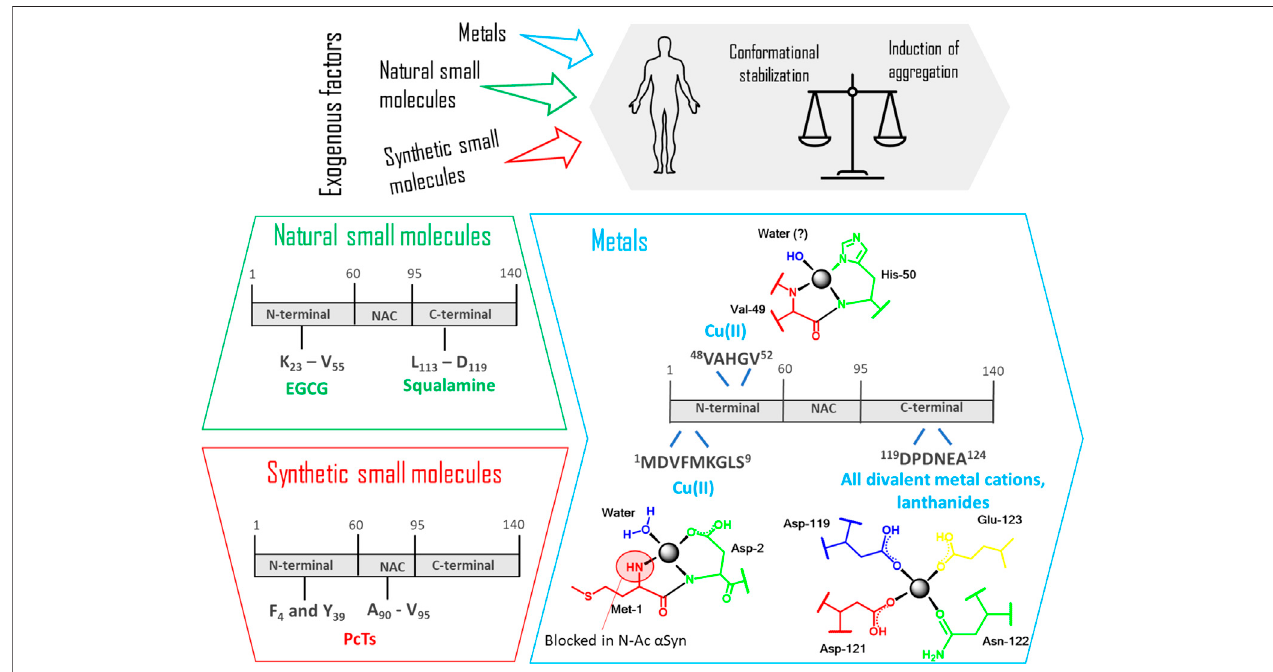
FIGURE 11 | Binding sites recognized in the interaction between α Syn monomer and different exogenous factors (natural and synthetic small molecules, metals). The coordination between the protein and these factors leads to a balance that is always shifting between conformational stabilization and induction of aggregation. In the box regarding “ metals, ” the speci fi c coordination modes of Cu(II), all divalent cations, lanthanides with the speci fi c amino acid residues are detailed. EGCG: Epigallocatechin gallate; PcTs: phthalocyanine tetra sulfonate.